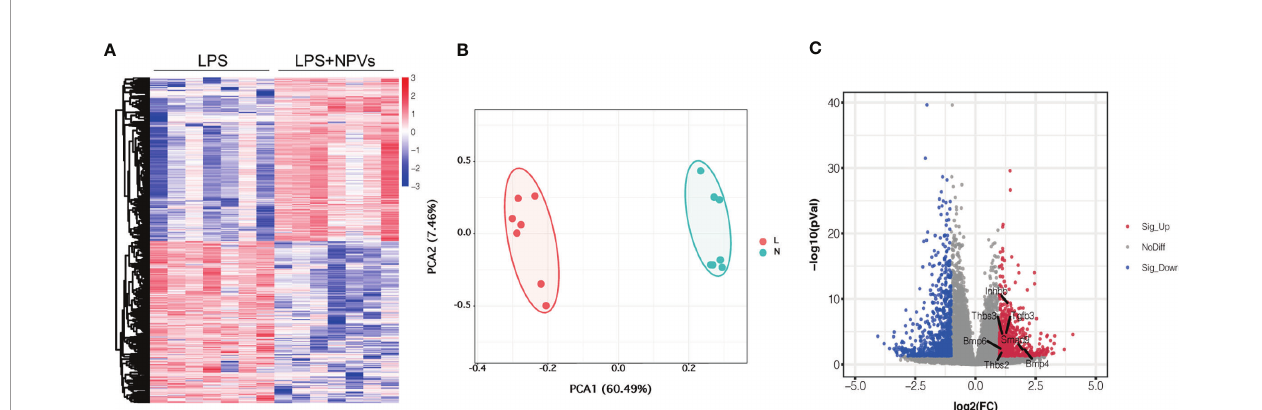
FIGURE 2 | Transcriptomic studies of macrophages treated with NPVs. (A) Differentially expressed genes in the transcriptomes of LPS group (left) and LPS+NPVs group (right) (n = 7, the screened differential genes were consistent with |log2FC| > 0.5, p < 0.05). (B) PCA analysis depicted that the LPS group (L) and the LPS+NPVs group (N) were signi fi cantly different in space. (C) Volcano plot showing upregulation of TGF- b pathway-related genes after NPS-treated macrophages. (Marked genes are signi fi cantly different, p <